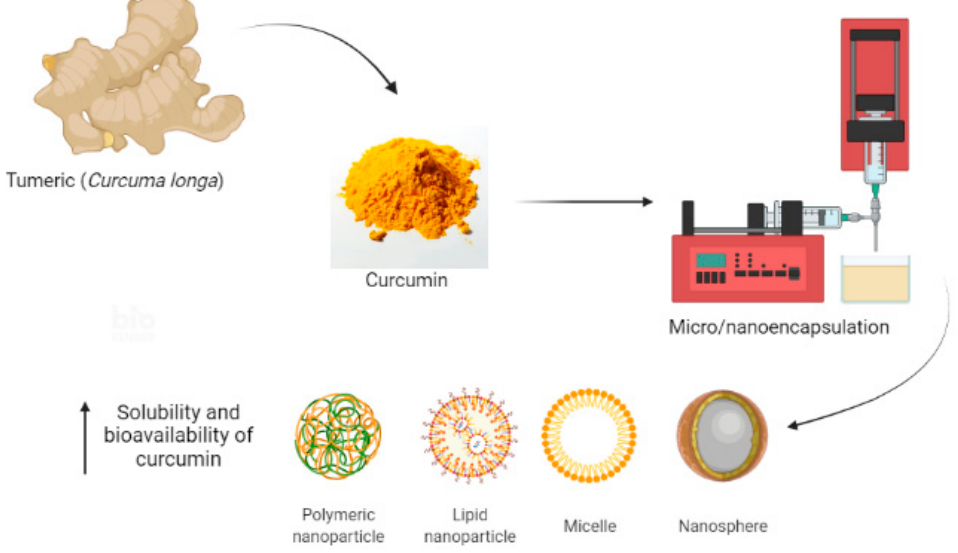
Figure 3. Overview of micro/nanoencapsulation of curcumin.